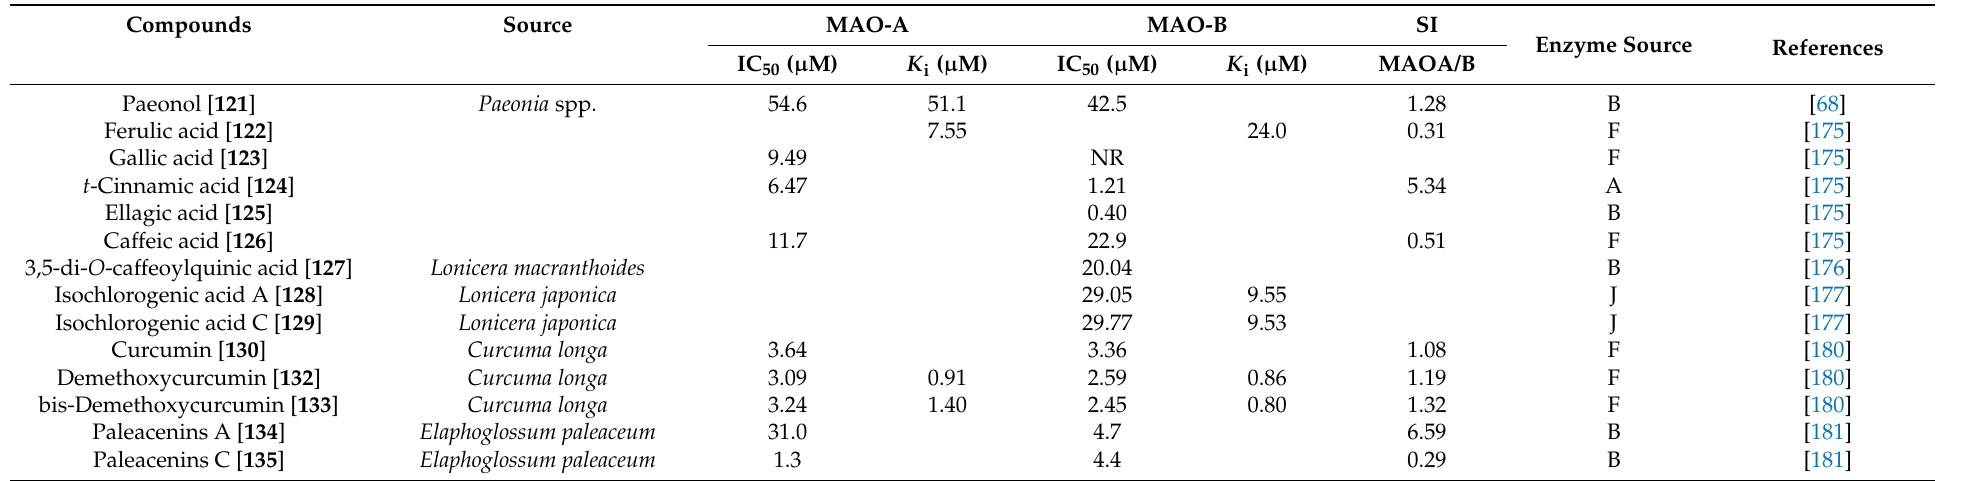
Table 6. Phenol and polyphenolic natural product inhibitors of MAO-A and